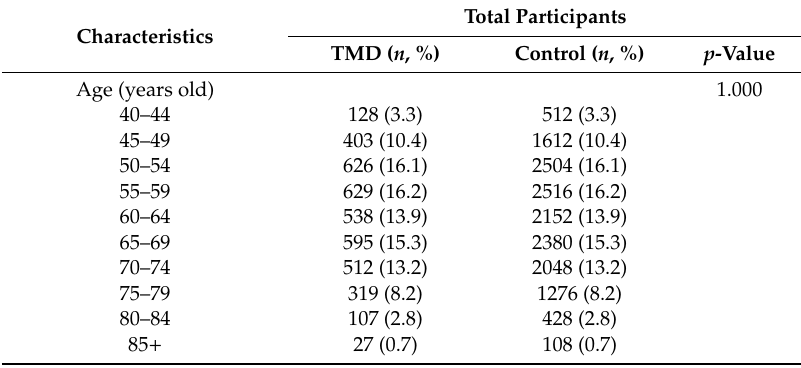
Table 1. General characteristics of